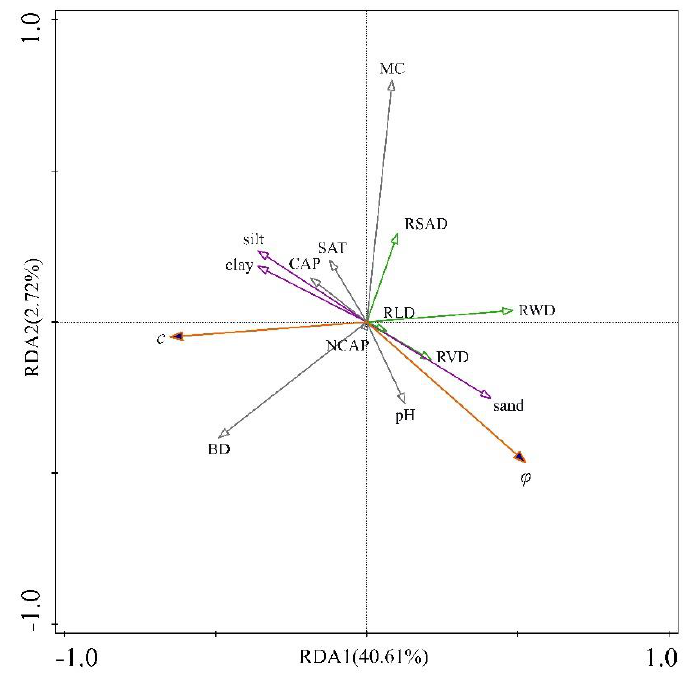
Figure 5. Redundancy analysis (RDA) of shear strength parameters of root soil and soil physical and chemical properties and root index. The angle and length of arrows indicate the direction and strength of the relationship between shear strength parameters of root and soil physical and chemical properties and root index. RLD stands for root length density; RSAD stands for roots surface area density; RVD stands for root volume density; RWD stands for root weight density; NCAP stands for non-capillary porosity; CAP stands for capillary porosity; SAT stands for total porosity; BD stands for bulk density; MC stands for moisture content; ϕ stands for internal frictional angle; c stands for cohesive force.